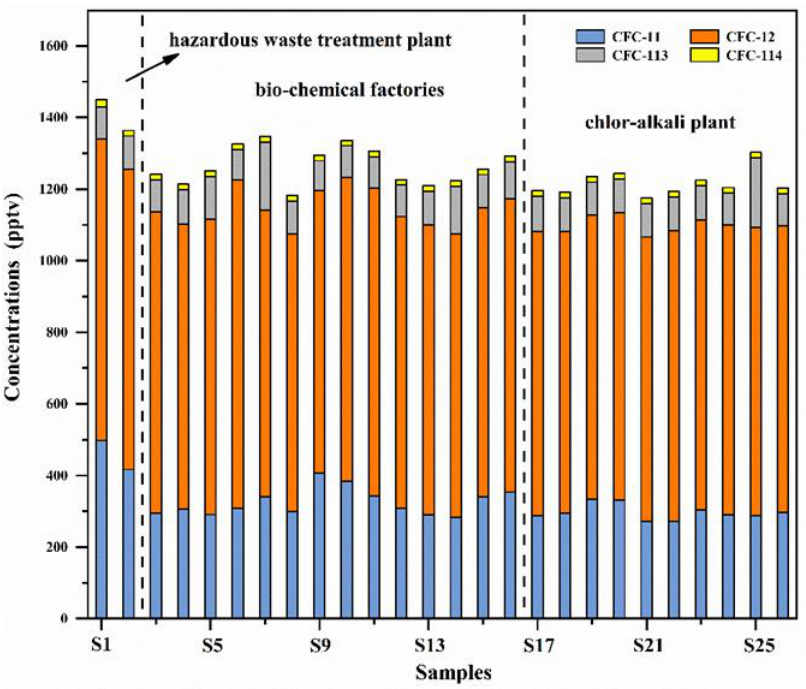
Figure 5. CFC concentrations of samples collected in Weifang (WF).